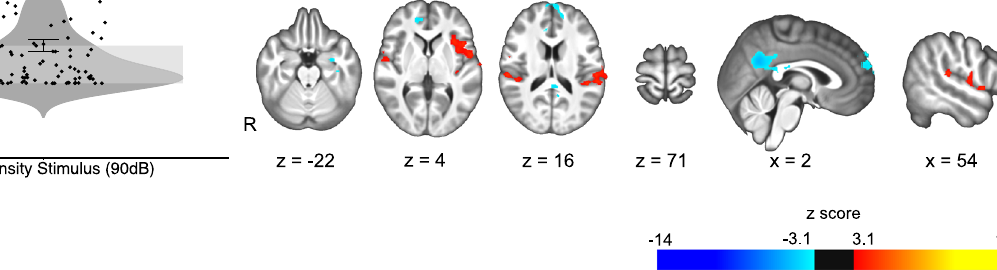
Fig. 4 Univariate analysis revealed widespread brain activation associated with high intensity auditory stimulation (90 dB) and related to perceived intensity. A Ratings of perceived auditory intensity in response to high intensity auditory stimuli ranged from 0 to 7.94. Mean and standard error represented by the bar plot. n = 97 participants. B Effect of high intensity auditory stimulation (90 dB) on brain activation. Areas of increased activation included putamen (Put), caudate nucleus (Cau), secondary somatosensory cortex (SII), primary auditory cortex (AI), insula (Ins), anterior cingulate cortex (ACC), and dorsolateral prefrontal cortex (DLPFC). Areas of decreased activation included bilateral amygdala and hippocampus (Amy/Hippo), primary somatosensory cortex (SI), posterior cingulate cortex (PCC) and precuneus (Prec). C High perceived intensity was associated with a greater increase in brain activation associated with high intensity stimulation in areas such as AI, SII, and insula and a greater decrease in brain activation in PCC and precuneus. Source data are provided as an xlsx Source Data fi le and activation maps are available on